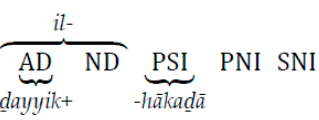
Figure 8. Reference Hierarchy for Sana’ani.